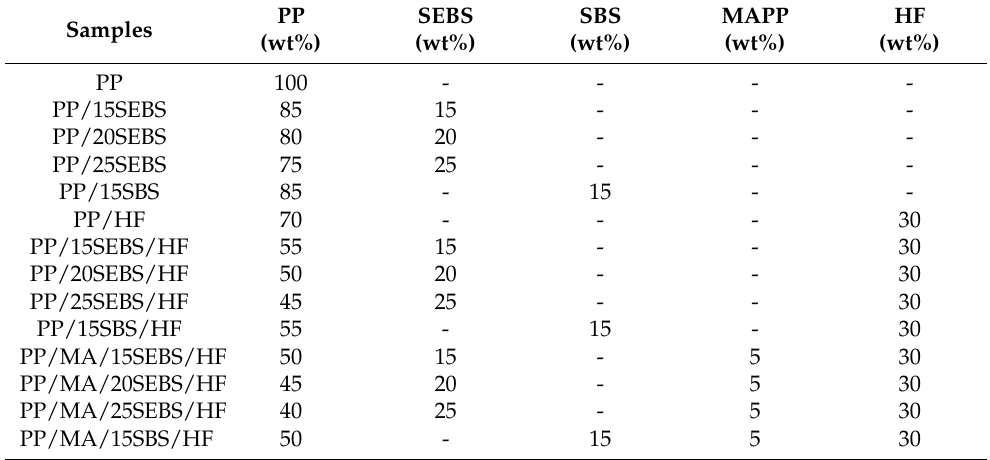
Table 1. Code names and compositions of the prepared blends and